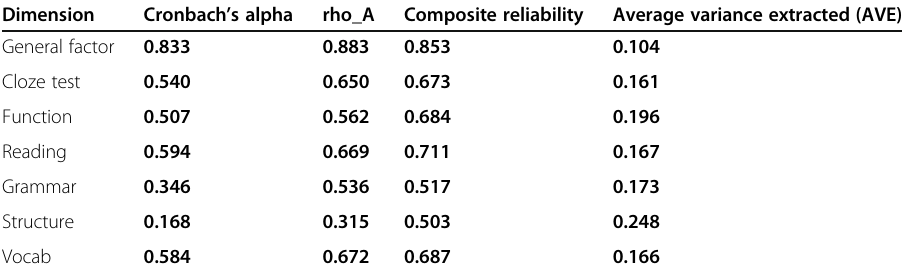
Table 1 Construct reliability and